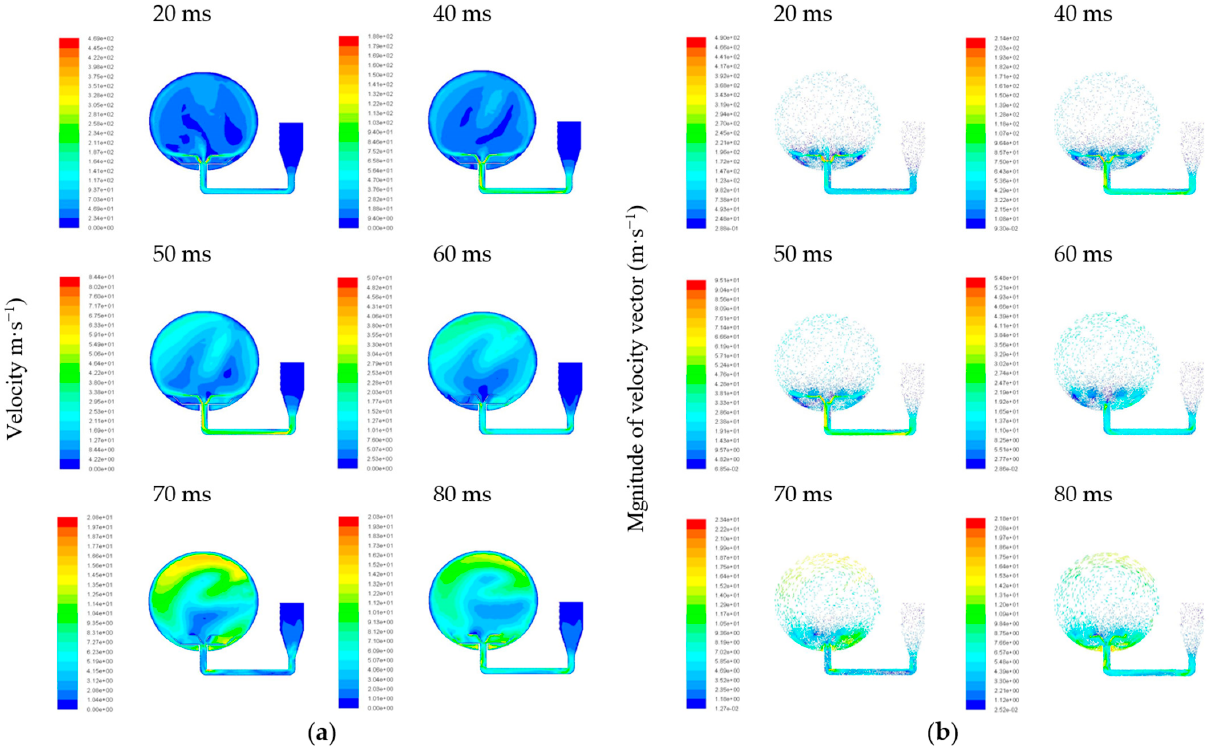
Figure 6. ( a ) Velocity and ( b ) magnitude of velocity vector of each particle profile for 250 g/m 3 Mg/air mixture during dispersion process.